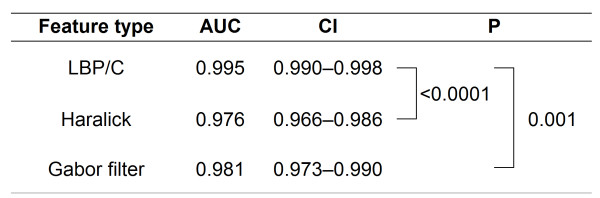
Summary of feature types and accuracy (area under the ROC curve) for each feature type in the test set (colorectal cancer images; n = 720) respectively. CI = confidence interval.